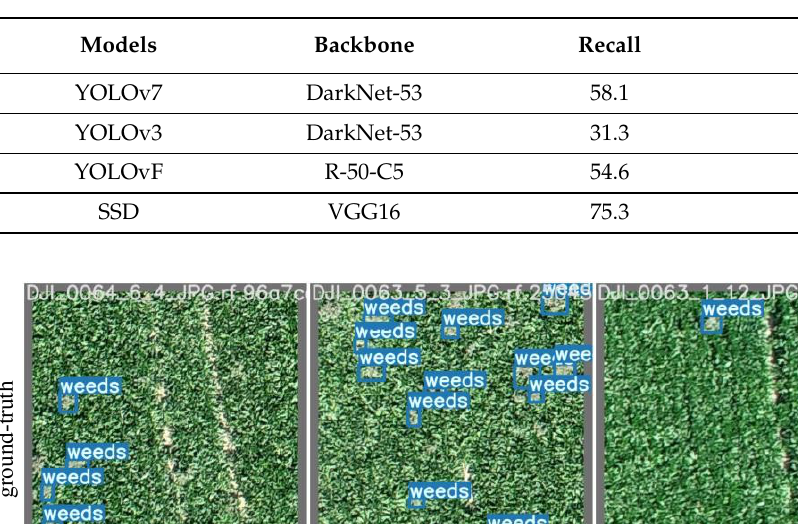
Table 7. Performance comparison for object detectors with CP dataset.